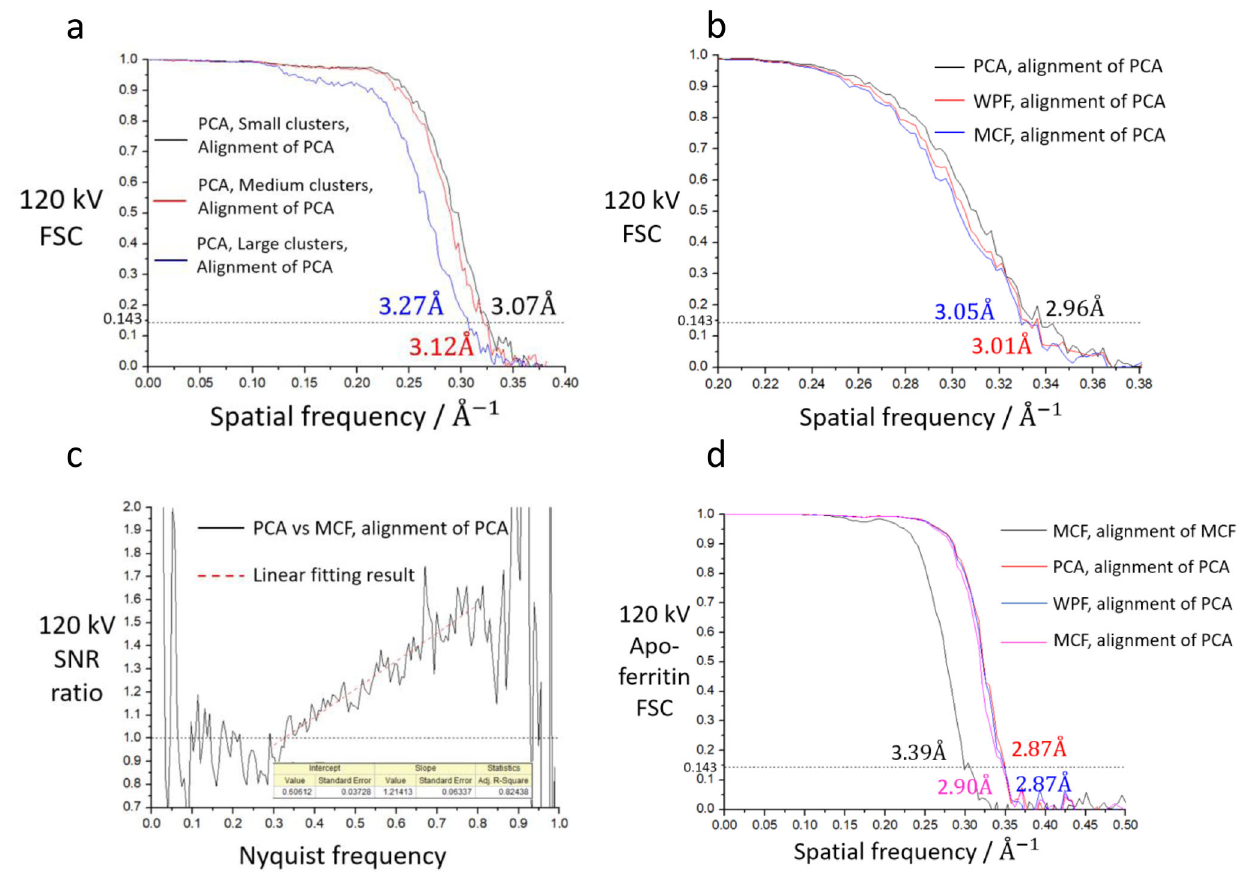
Fig. 3 Performances of PCA and WPF at 120 kV. a FSC curves for 3 types of clusters in Coxsackievirus A10 dataset at 120 kV with PCA counting algorithm. Each pair of reconstructions holds roughly the same number of clusters (~81.4% of ‘ small-sized ’ clusters, ~71.3% of ‘ medium-sized ’ clusters and 100% of ‘ large-sized ’ clusters). b FSC curves of PCA, WPF and MCF counting algorithm in Coxsackievirus A10 dataset at 120 kV. All clusters are used. c SNR ratio between PCA and MCF. The linear fi tting interval is 0.30~0.80 Nyquist frequency. d FSC curves of PCA, WPF and MCF counting algorithm in apo-ferritin dataset at 120 kV. Alignment of MCF means we re-do SPA process since CTF estimation, and particles are re-picked, re-classi fi ed and re-re fi ned within images from MCF algorithm. All the resolution of reconstructions based on gold-standard FSC criterion marks on the